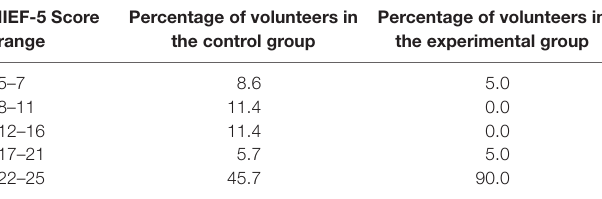
tABLe 4 | Distribution of the IIEF-5 scores over the 5 considered ranges, for both the control and the experimental groups. IIeF-5 score range